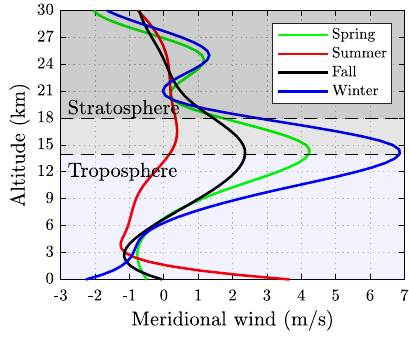
Figure 13. HWM14 wind profile over Mumbai, India.